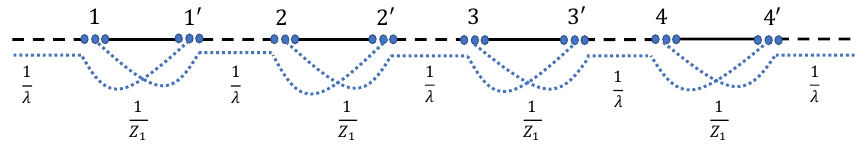
Figure 22 . “Boundary” lines for the equilibrium approximation for R pq with n = 4 .